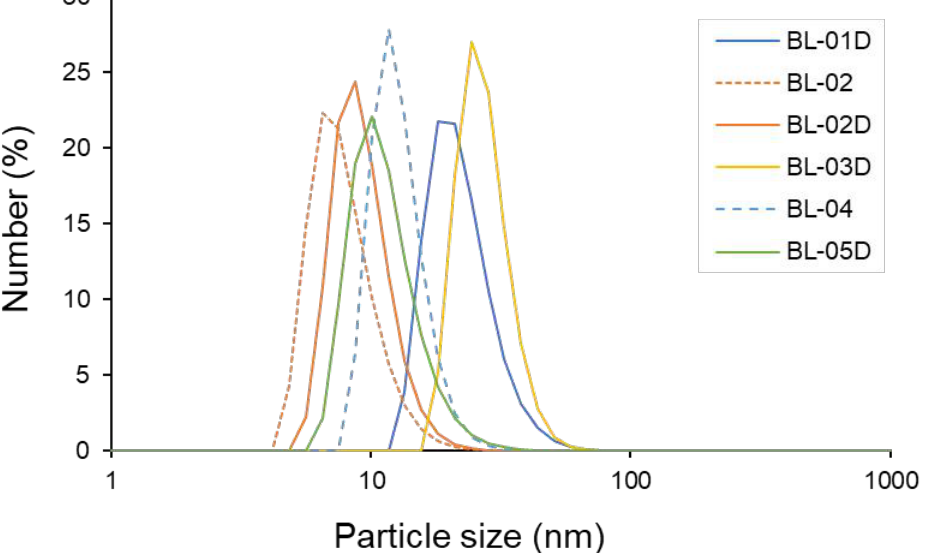
Figure 4. Micelle-size-distribution of polymers; BL-01D) 0.1% BL-01 aqueous solution from DEG solution; BL-02) 0.1% BL-02 aqueous solution from polymer powder; BL-02D) 0.1% BL-02